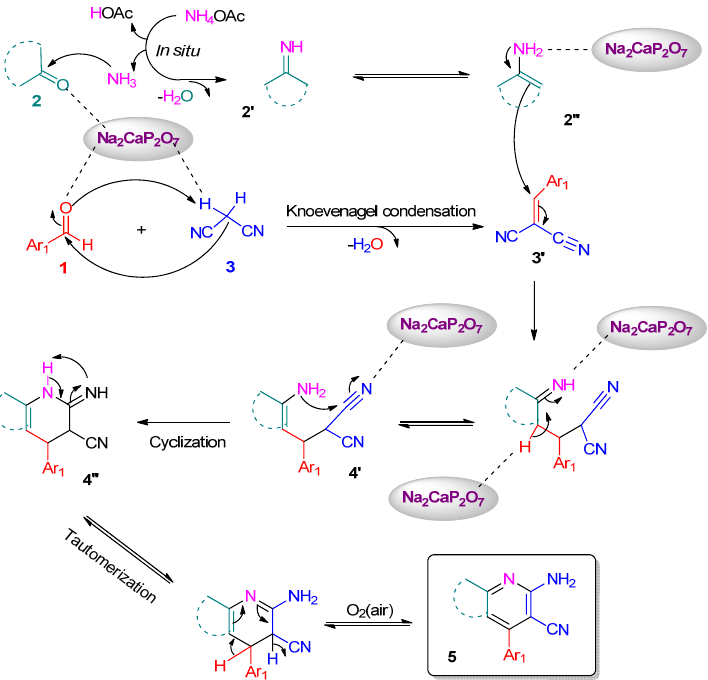
Scheme 3. Proposed mechanism for Na 2 CaP 2 O 7 -catalyzed synthesis of 2-amino-3-cyanopyridine derivatives.